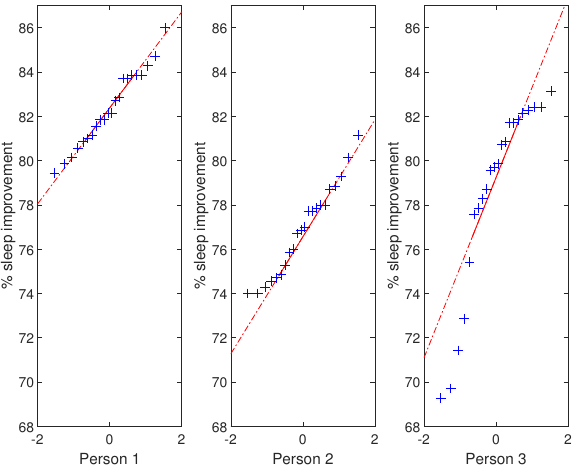
Figure 25. Q-Q plot for three random people in the sample.